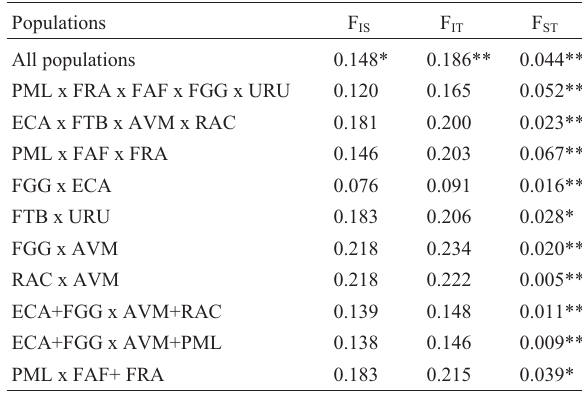
Table V - Estimates of Wright F-statistics of Wright of 328 adult individuals from nine populations of Araucaria angustifolia . Locus